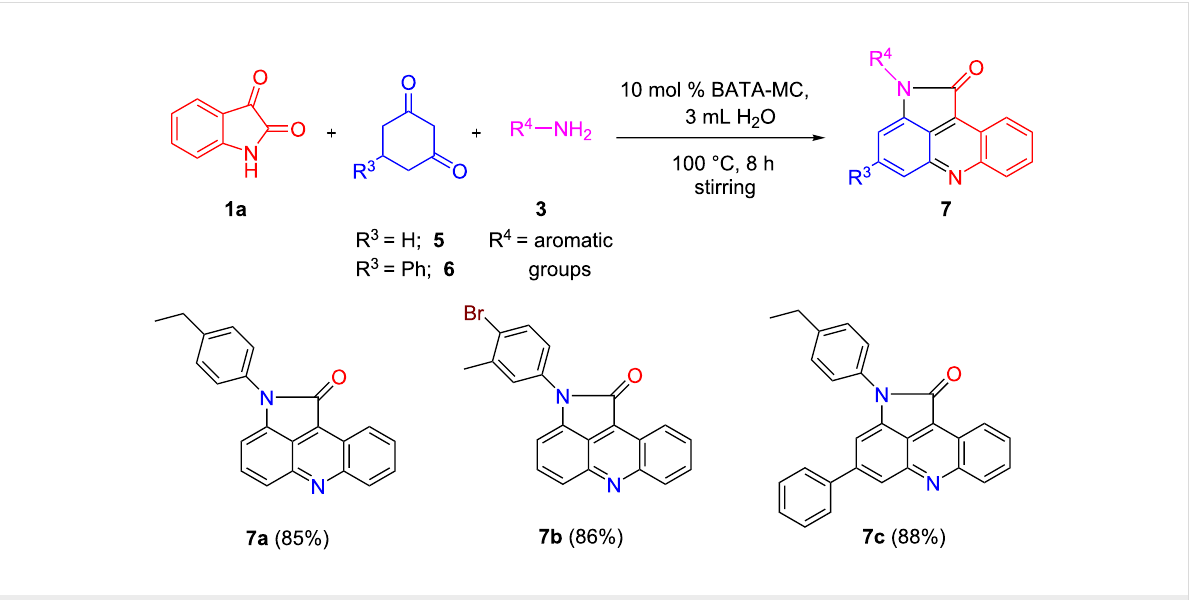
Scheme 2: BATA-MC-catalyzed synthesis of pyrrolo[2,3,4- kl ]acridinone derivatives.